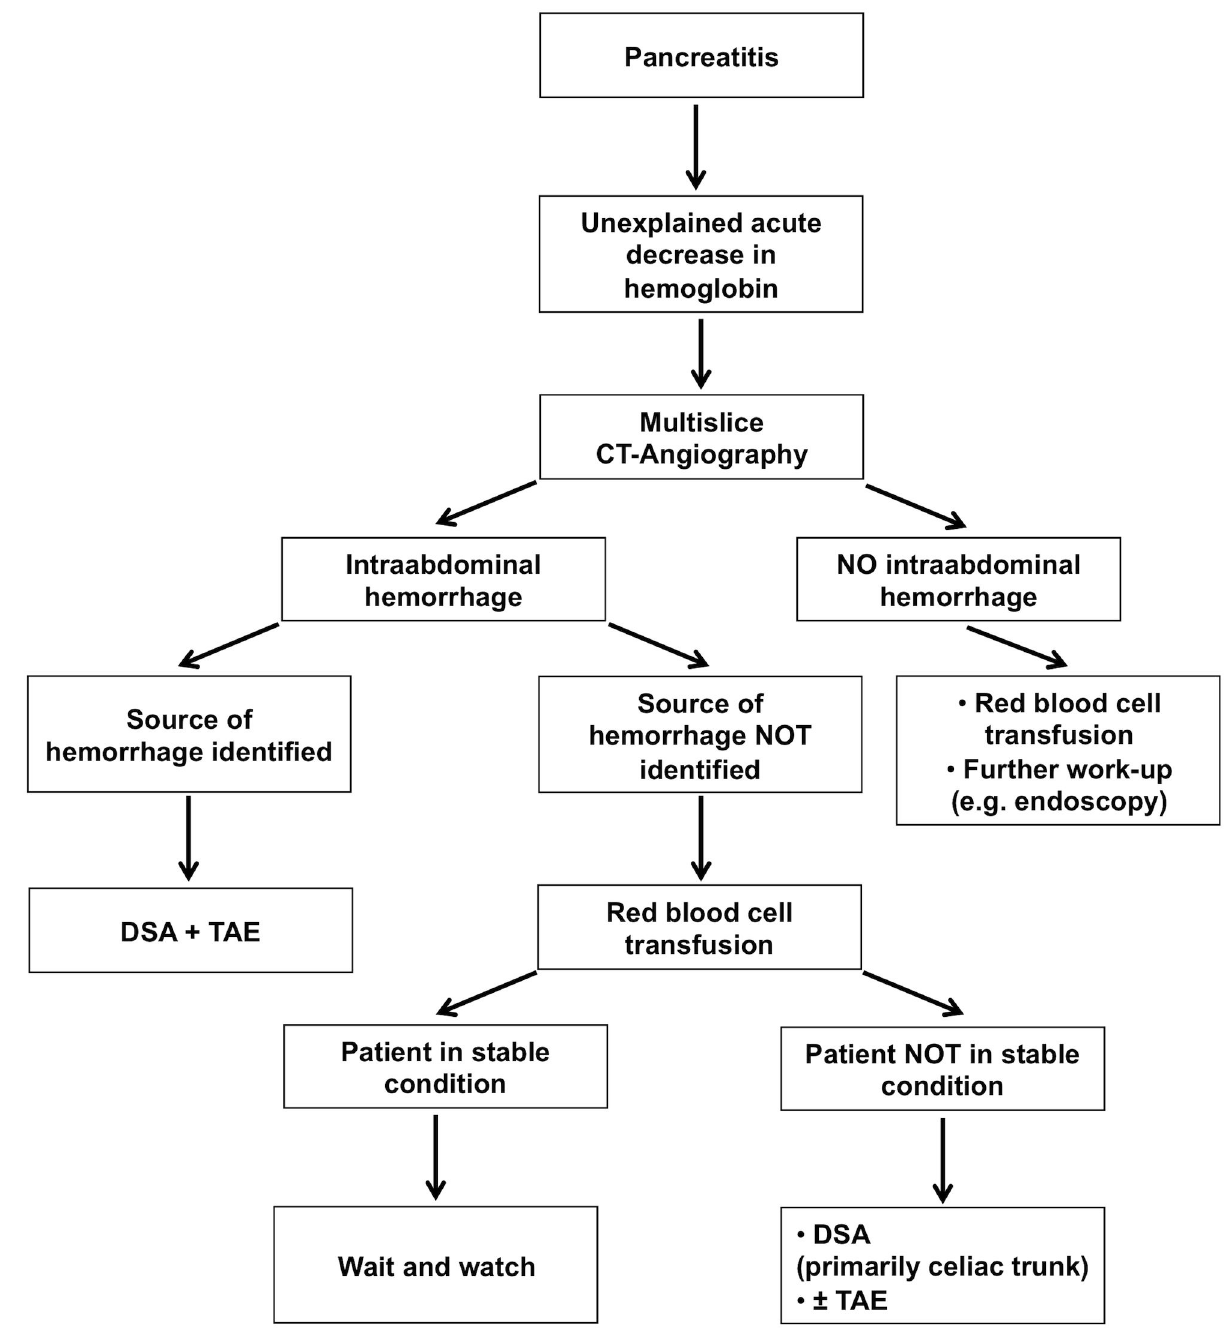
Figure 2. Algorithm for the management of intraabdominal hemorrhage in pancreatitis. CT, computed tomography; DSA, digital subtraction angiography;. TAE, transcatheter arterial embolization.